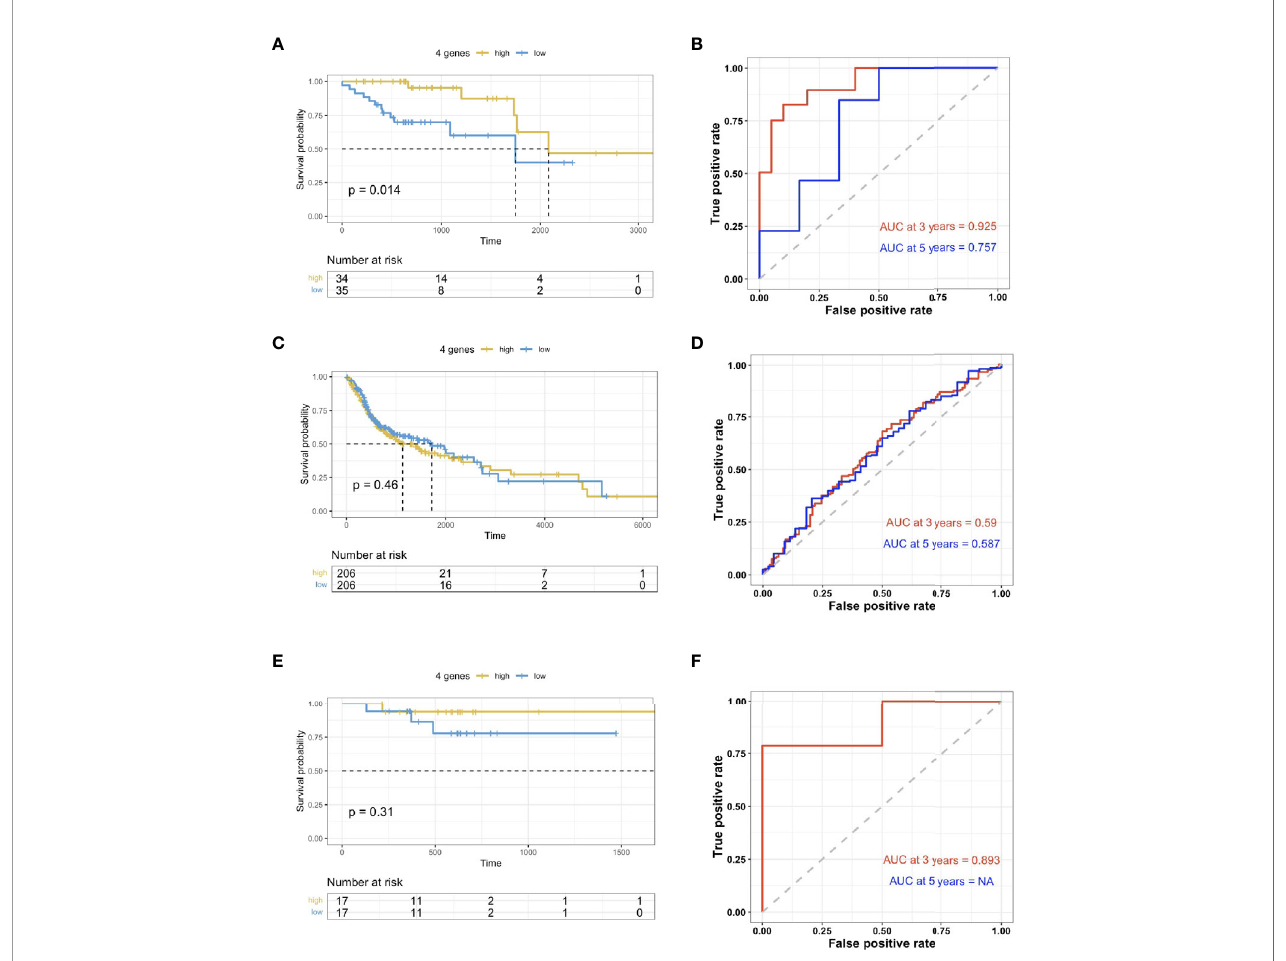
FIGURE 5 | Validation of prognosis gene labels for HNSCC cases. (A) Kaplan-Meier (KM) analysis of the risk group that were de fi ned with CD8+ T cell-correlated gene tags in the TCGA dataset for HPV+ HNSCC. (B) KM analysis of the risk group that were de fi ned with CD8+ T cell-correlated gene tags in the TCGA dataset for HPV- HNSCC. (C) KM analysis of the risk group that were de fi ned with CD8+ T cell-correlated gene tags in the TCGA provisional dataset for HPV+ HNSCC. (D) Three- and fi ve-year ROC survival curves from the TCGA dataset for HPV+ HNSCC. (E) Three- and fi ve-year ROC survival curves from the HPV- HNSCC TCGA dataset. (F) Three- and fi ve-year ROC survival curves from the TCGA provisional dataset for HPV+